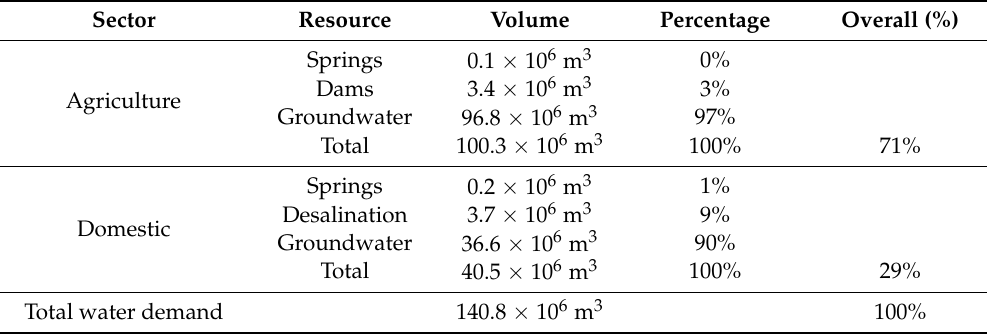
Table 3. Annual water demands by sector and sources of supply in 2010 [27].